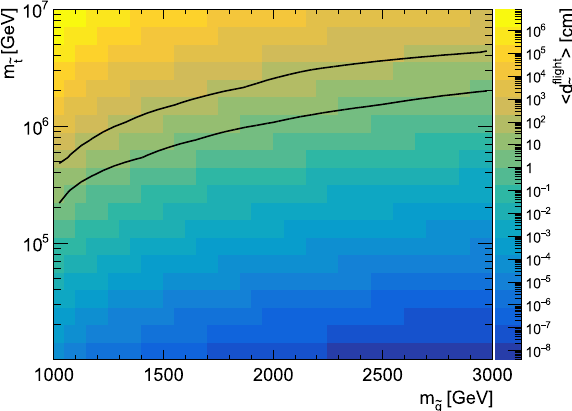
Fig. 62 Feynman diagrams of gluino pair production by gluon fusion